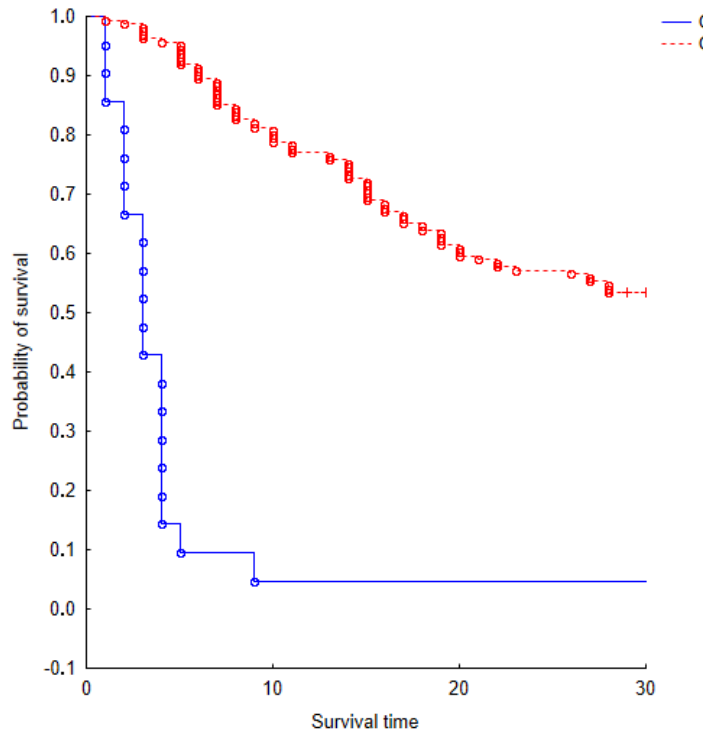
Figure 2. The Kaplan-Meier survival model for two groups of Experience Factors over a period of one month.